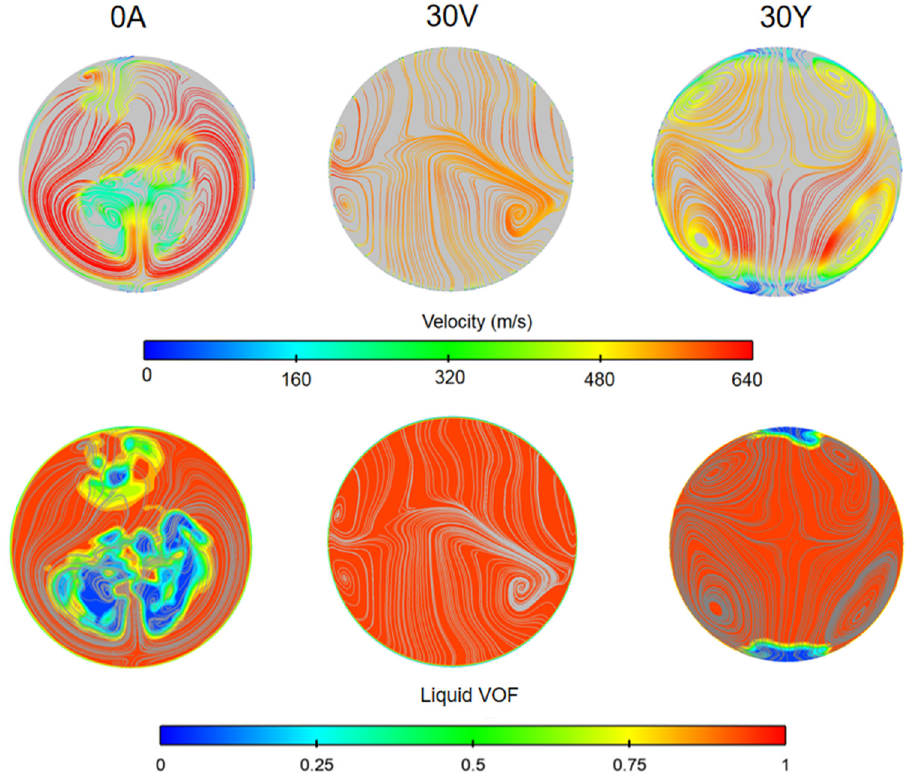
Figure 10: Comparison of the outlet velocity fi